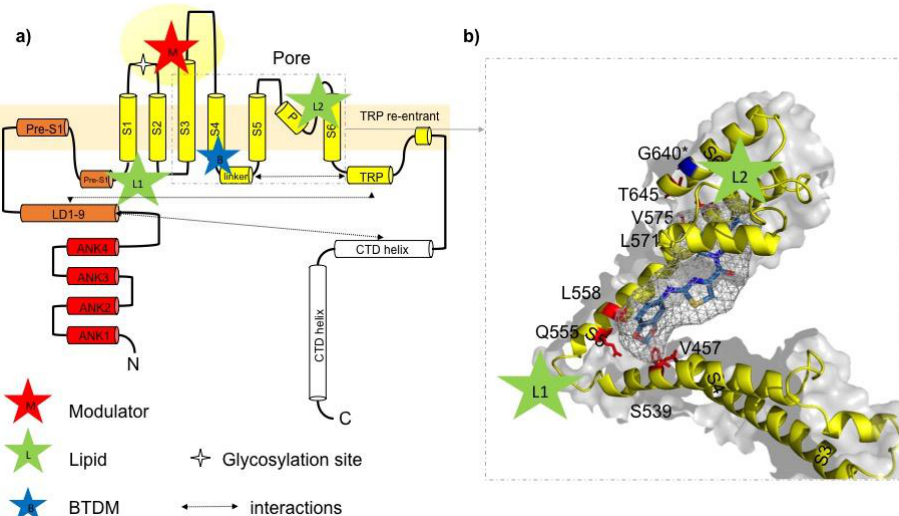
Figure 2. Ligand-channel interactions and potential drug binding sites in TRPC3. ( a ) Schematic illustration of the domain structure of one TRPC3 channel subunit according to information provided in Fan et al. [7]. Lipid binding sites (green stars) are indicated with L1 (formed by LD9, pre-S1, S1, S4, and S4–S5 linker) and L2 (between p-loop and S6 helix); potential modulator binding site (M) represented by a cavity (extracellular domain) formed by the extended S3 helix, S1–S2 and S3–S4 linkers as previously identified [7]. Proposed BTDM binding site formed by S3, S4–S5 linker, S4, S5, and S6 identified by Tang et al. [8]. ( b ) Detailed view on postulated 2-(benzo[d][1,3]dioxol-5-ylamino)thiazol-4-yl) (( 3S , 5R )-3,5-dimethylpiperidin-1-yl)methanone (BTDM) binding site in TRPC3: amino acids in the TRPC3 sequence, corresponding to the TRPC6 BTDM binding site are marked in red. The BTDM molecule is only schematically introduced into the TRPC structure and not adjusted in size. The glycine residue G652 (here G640, isoform 1/Q13507-1 in UniProt) identified as crucial for recognition and accommodation of lipid activators is highlighted in blue [14]. The BTDM molecule is schematically placed into the proposed binding